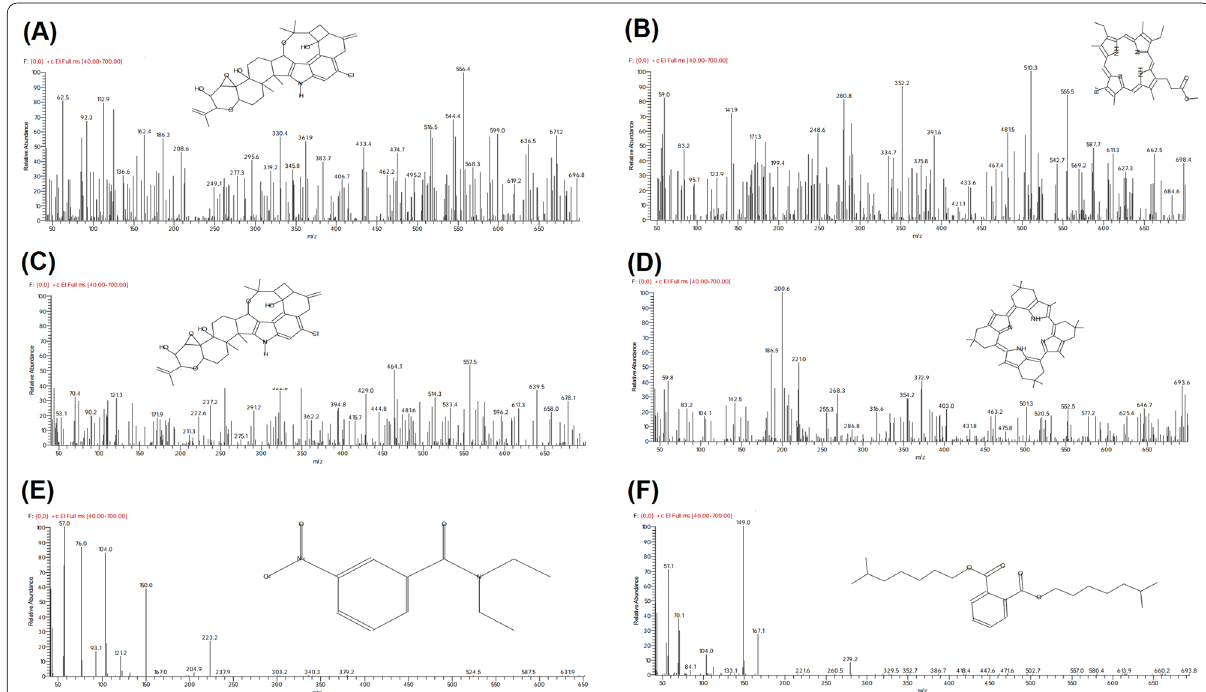
Fig. 5 Chromatograms of the identified compounds with their structures. A, B From A. sydowii AUMC14506 cultures. C, D From A. flavus AUMC14507 cultures. E, F From L. theobromae AUMC14508